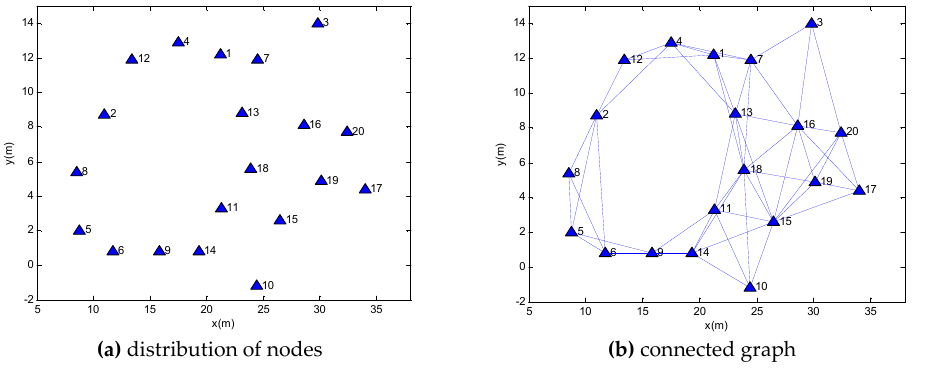
Figure 11. The network topology.